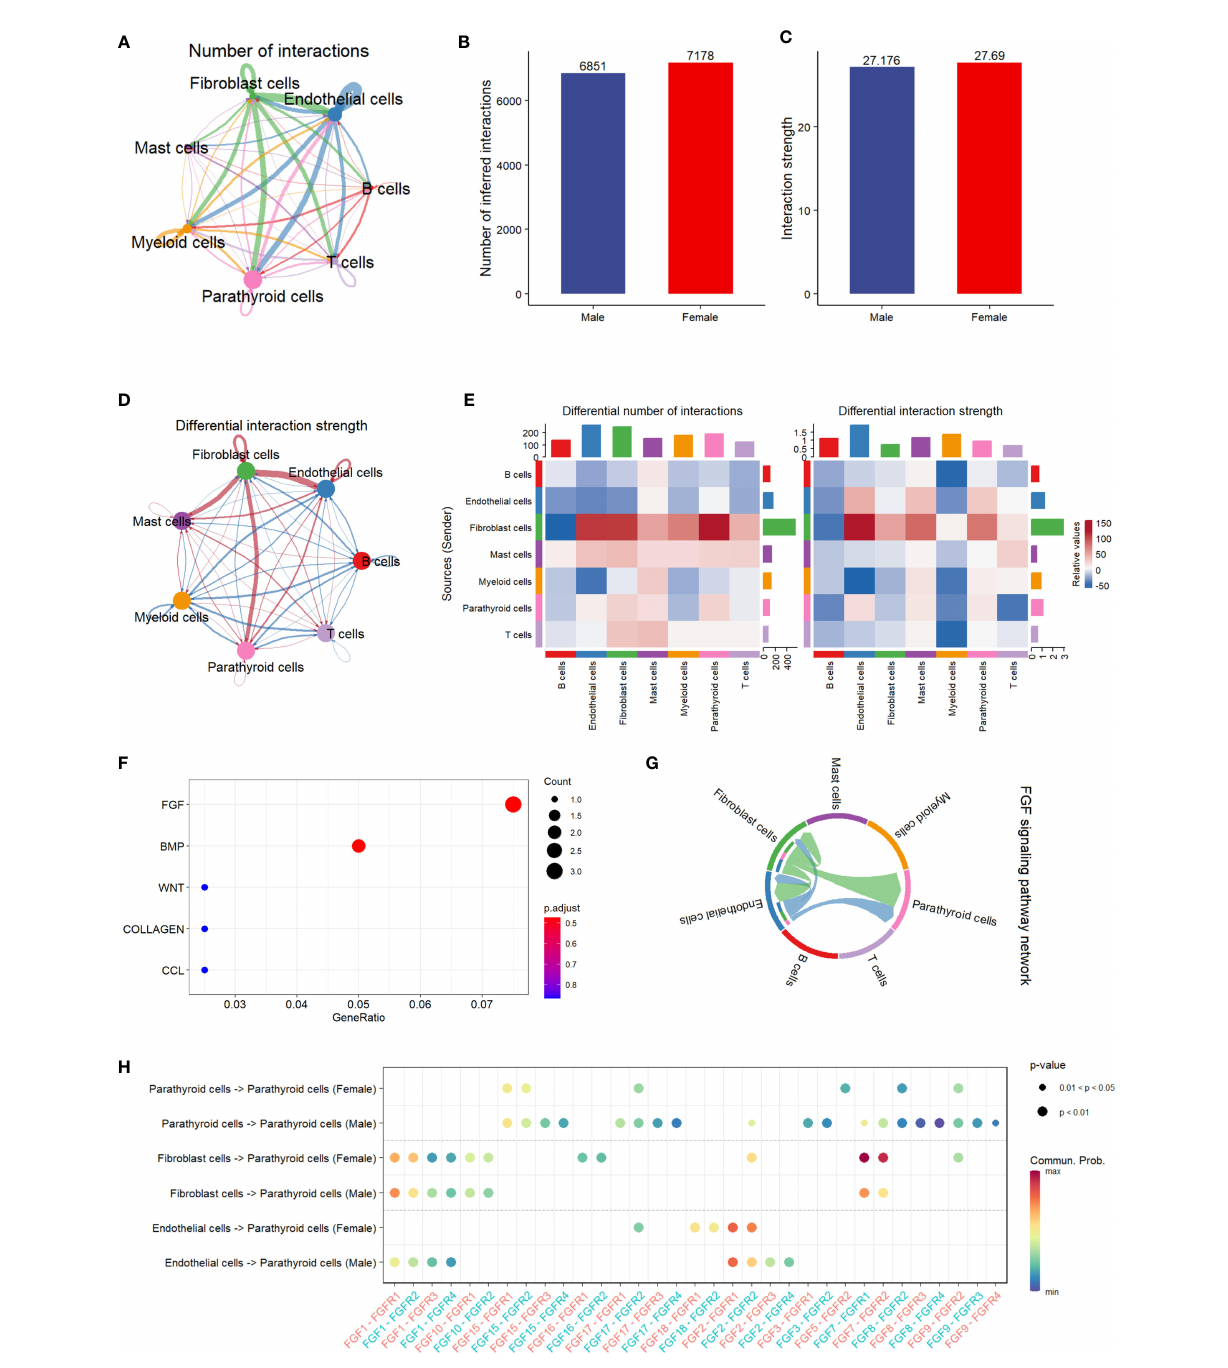
FIGURE 3 Cell communication analysis of PHPT patient samples. (A) String plot of the aggregated cell-cell communication network, showing the number of interactions between cell types. (B) Comparison of the number of interactions between male and female patients.ns=not statistically signi fi cant (unpaired t-test). (C) Comparison of the interaction strength between male and female patients. ,ns=not statistically signi fi cant (unpaired t-test). (D) Differential interaction strength comparison between male and female patients. (E) Heatmap of interaction numbers and strength in different cell types. (F) Pathway enrichment analysis of genes differentially expressed in two sexes. (G) FGF signaling pathway network of all cell types. (H) Enriched receptor-ligand pairs between parathyroid cells and other cell types in the FGF